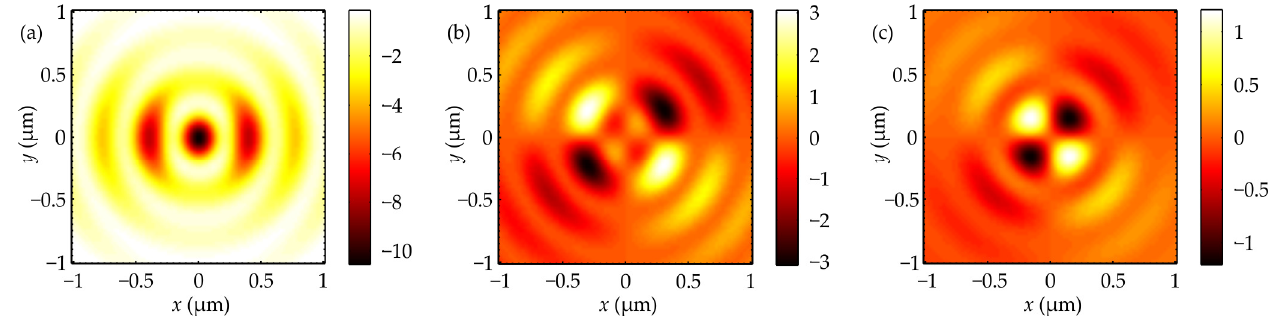
Figure 6. Stokes vector components s 1 ( a ), s 2 ( b ), and s 3 ( c ) at a distance λ after the focal plane.